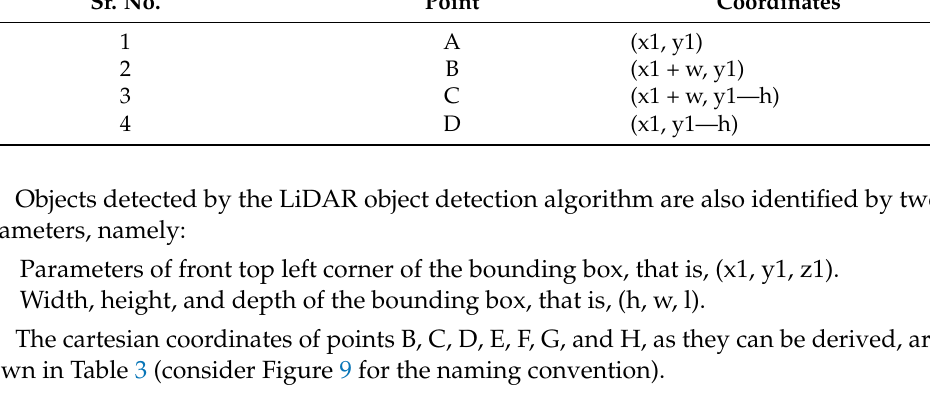
Table 3. Cartesian coordinates of the 3D bounding box. Sr.